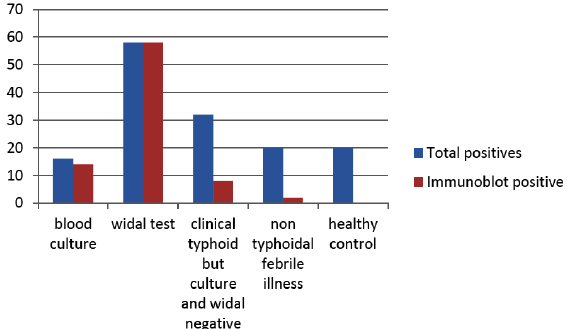
Fig. 1. Categorywise results of Immunoblot Test